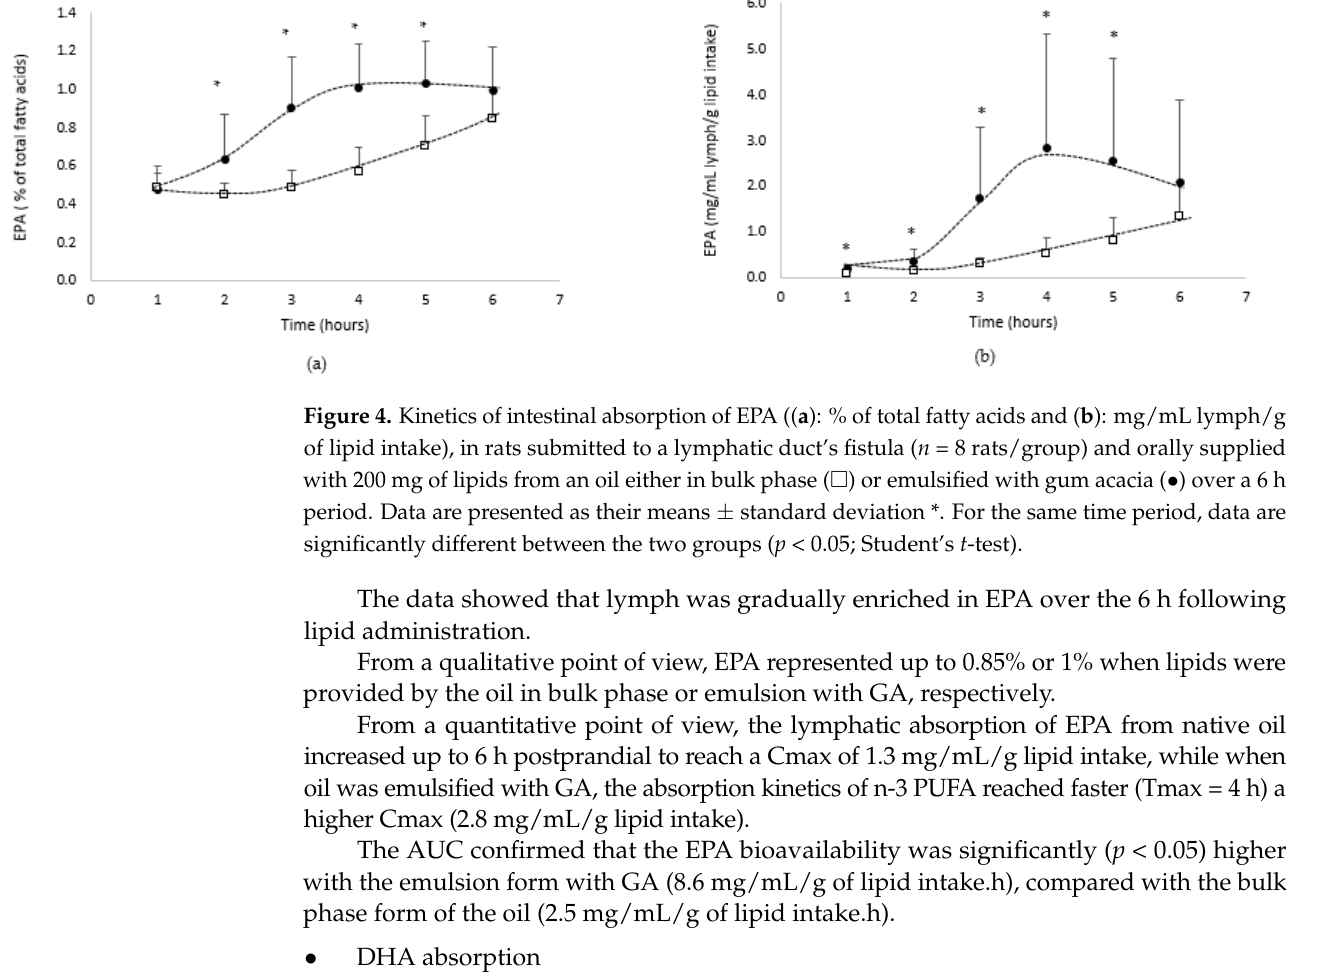
Figure 5. Kinetics of intestinal absorption of DHA (( a ): % of total fatty acids and ( b ): mg/mL lymph/g of lipid intake), in rats submitted to a lymphatic duct’s fistula ( n = 8 rats/group) and orally supplied with 200 mg of lipids from an oil either in bulk phase ( (cid:0) ) or emulsified with gum acacia ( • ) over a 6 h period. Data are presented as their means ± standard deviation *. For the same time period, data are significantly different between the two groups ( p < 0.05; Student’s t -test).